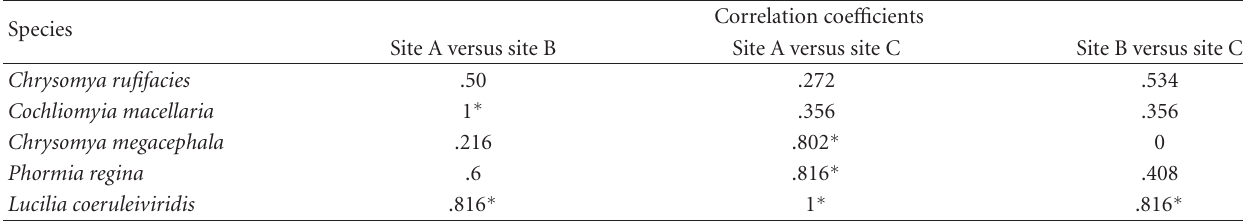
Table 4: Dichotomous correlations of blow fly adults over a 10-day period among three sites, each with a single alligator carcass.